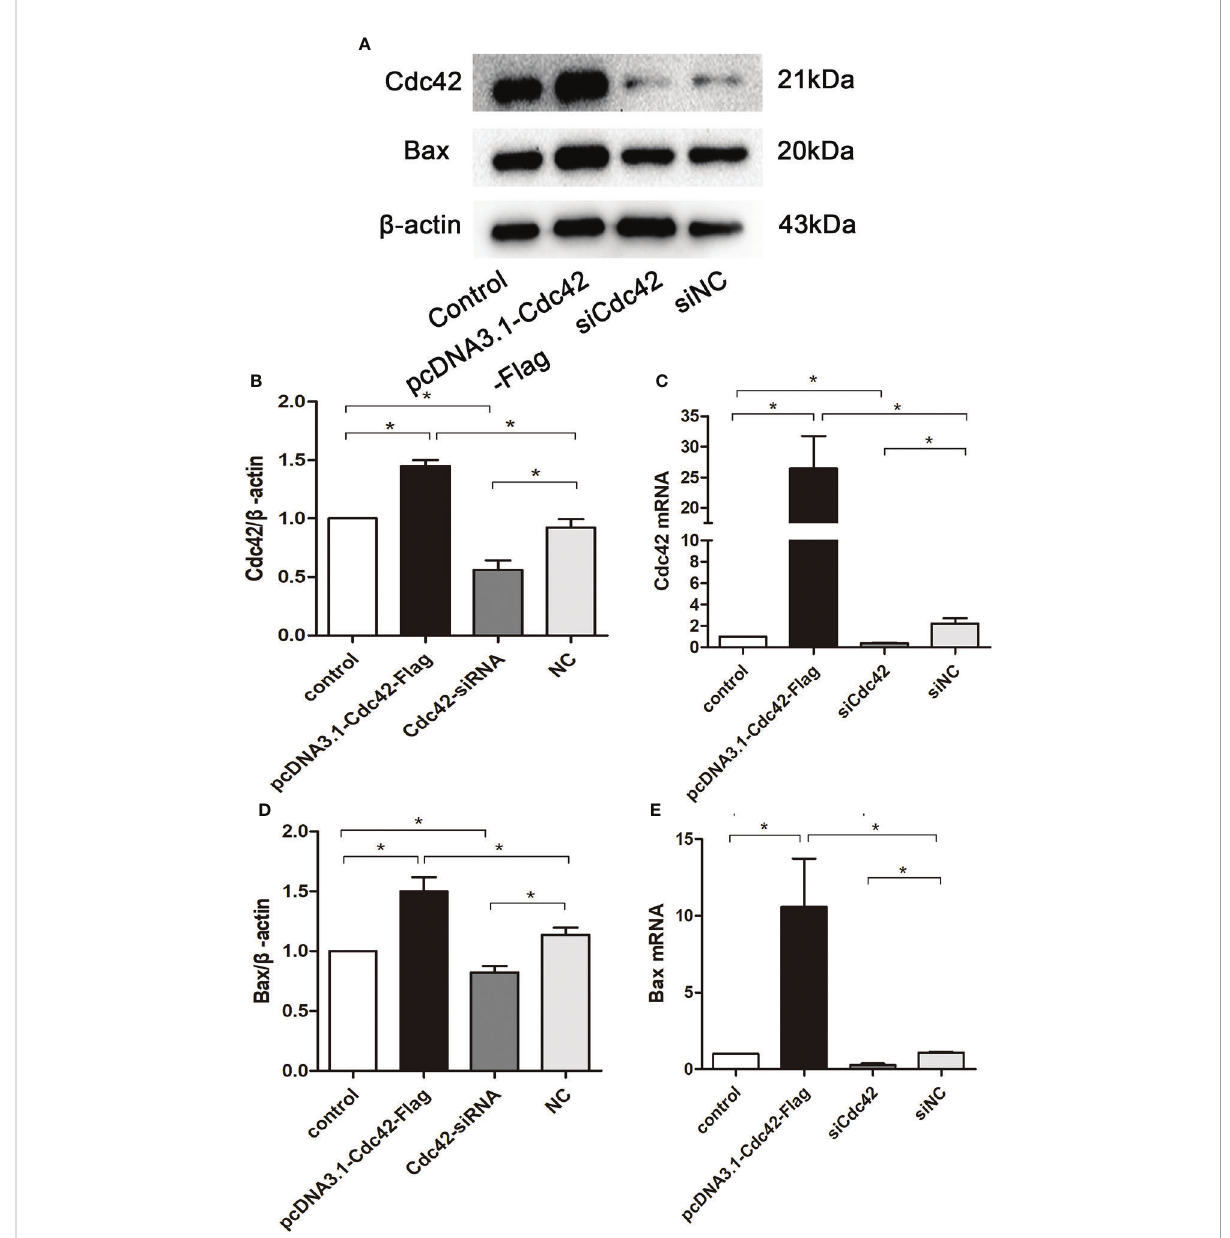
FIGURE 3 Upregulation of Cdc42 increased the Bax levels in MPC5 cells. ( A , B , D ) The protein expression levels of Cdc42 and Bax were detected. When transfected with a plasmid carrying the Cdc42 gene, the Cdc42 and Bax proteins were signi fi cantly increased compared to the negative control, whereas transfection with Cdc42-siRNA reduced the Cdc42 and Bax protein levels. ( C , E ) The mRNA expression of Cdc42 and Bax increased in plasmid-transfected podocytes compared to the control; conversely, the mRNA expression of Cdc42 and Bax decreased in siCdc42-transfected podocytes. The data were from at least three independent experiments and are presented as mean ± SEM; * P <